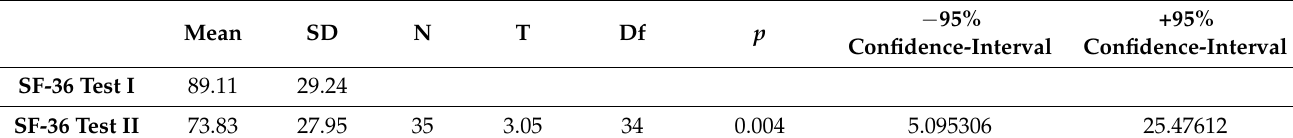
Table 4. Results achieved by patients on the SF-36 scale during the first and second tests (Student’s t -test).